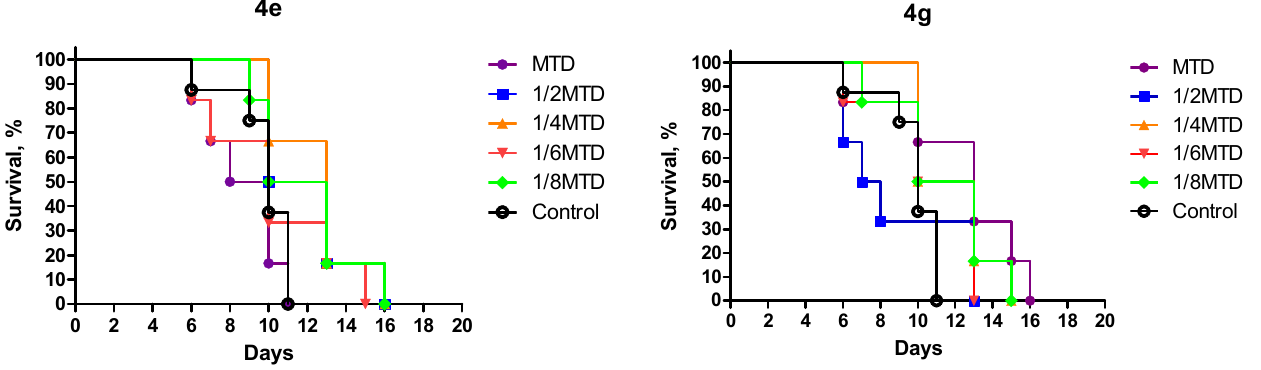
Figure 10. Survival curves of BDF 1 mice with leukemia P388 after a single intraperitoneal injection of compounds 4e and 4g.